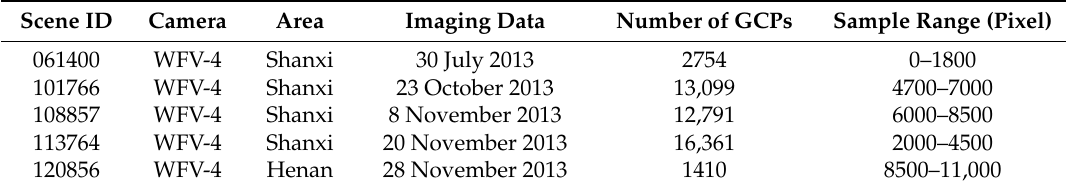
Table 3. Details of the GF-1 WFV-4 calibration images.